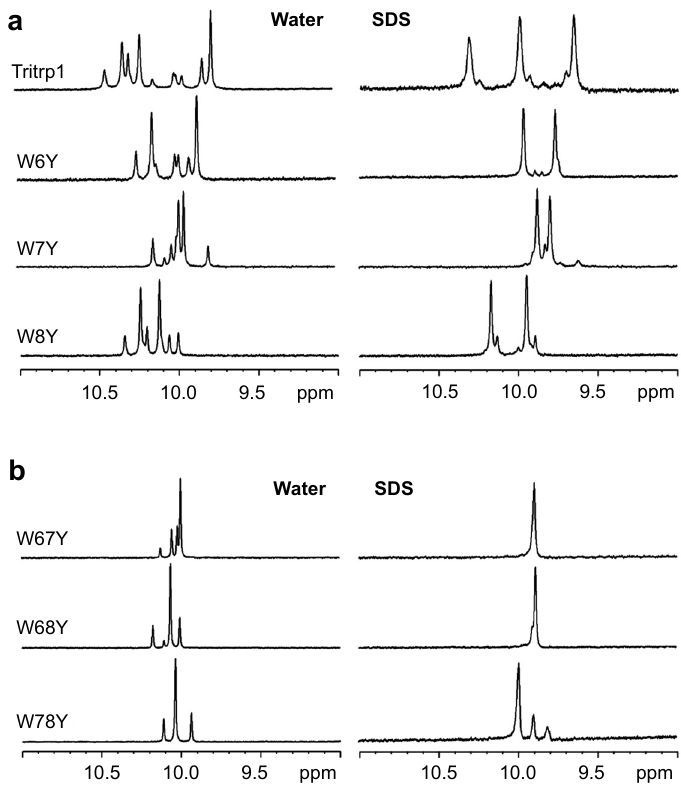
Figure 1. One-dimensional proton NMR spectra recorded for the H ε 1-tryptophan region of single- ( a ) and double- ( b ) Trp-substituted Tritrp1 peptides with Tyr in aqueous solution ( left ) and in the presence of d 25 -SDS micelles ( right ) at 37